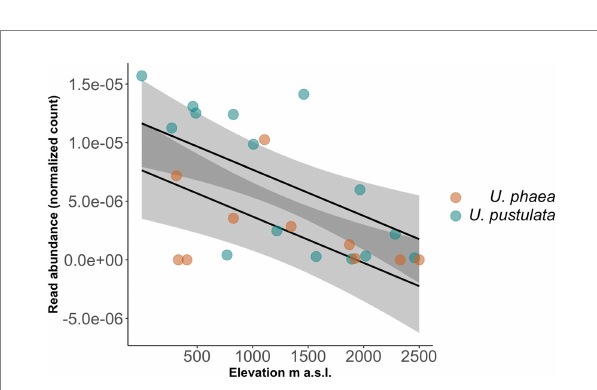
FIGURE 3 Read abundance of identified ortholog decreases significantly with increasing elevation across U. phaea (brown circles, lower regression line) and U. pustulata (blue circles, upper regression line)